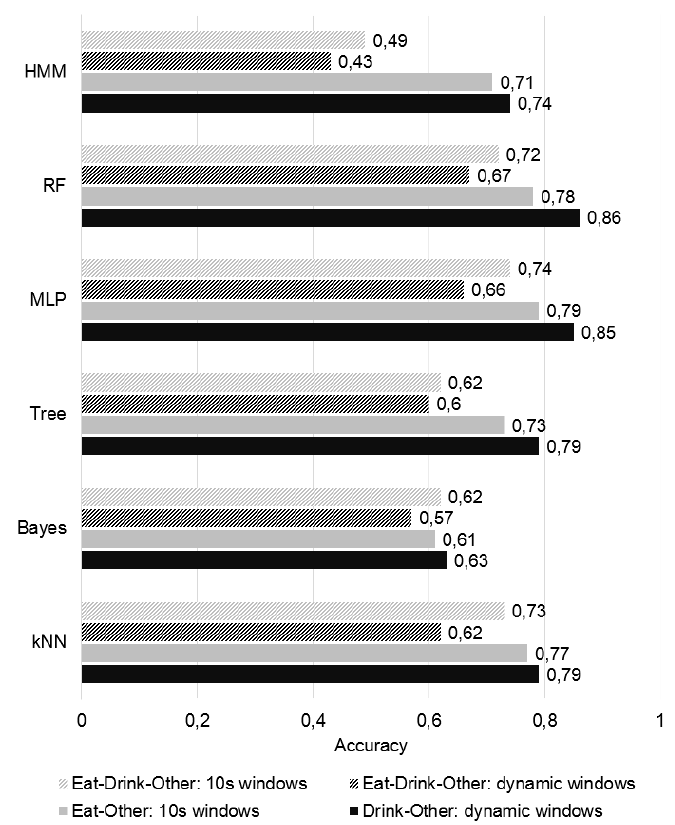
Figure 4. Comparison between overall accuracy of multi-class (striped) vs. binary (full) classification models generated in the sequence of different segmentation